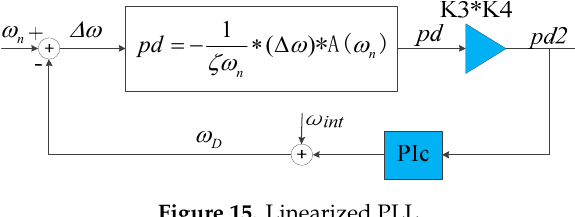
Figure 15. Linearized PLL.